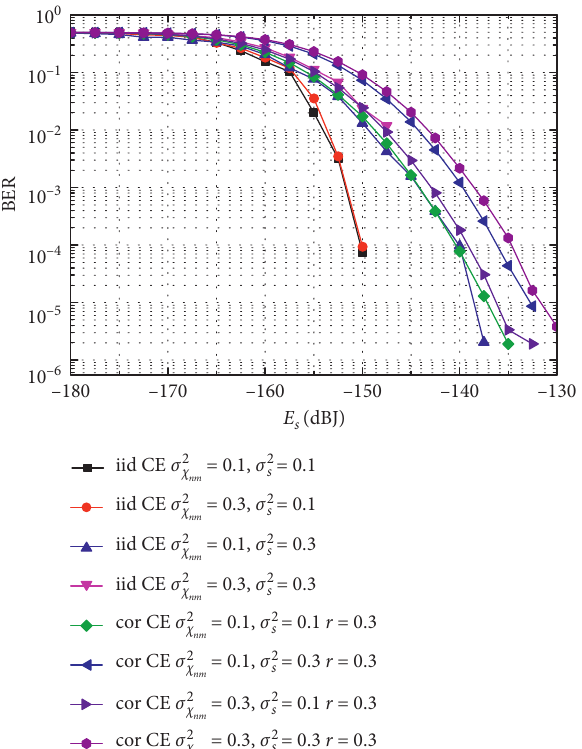
Figure 5: BER with combined effects over correlated channel for different atmospheric turbulence and pointing error jitter variance.